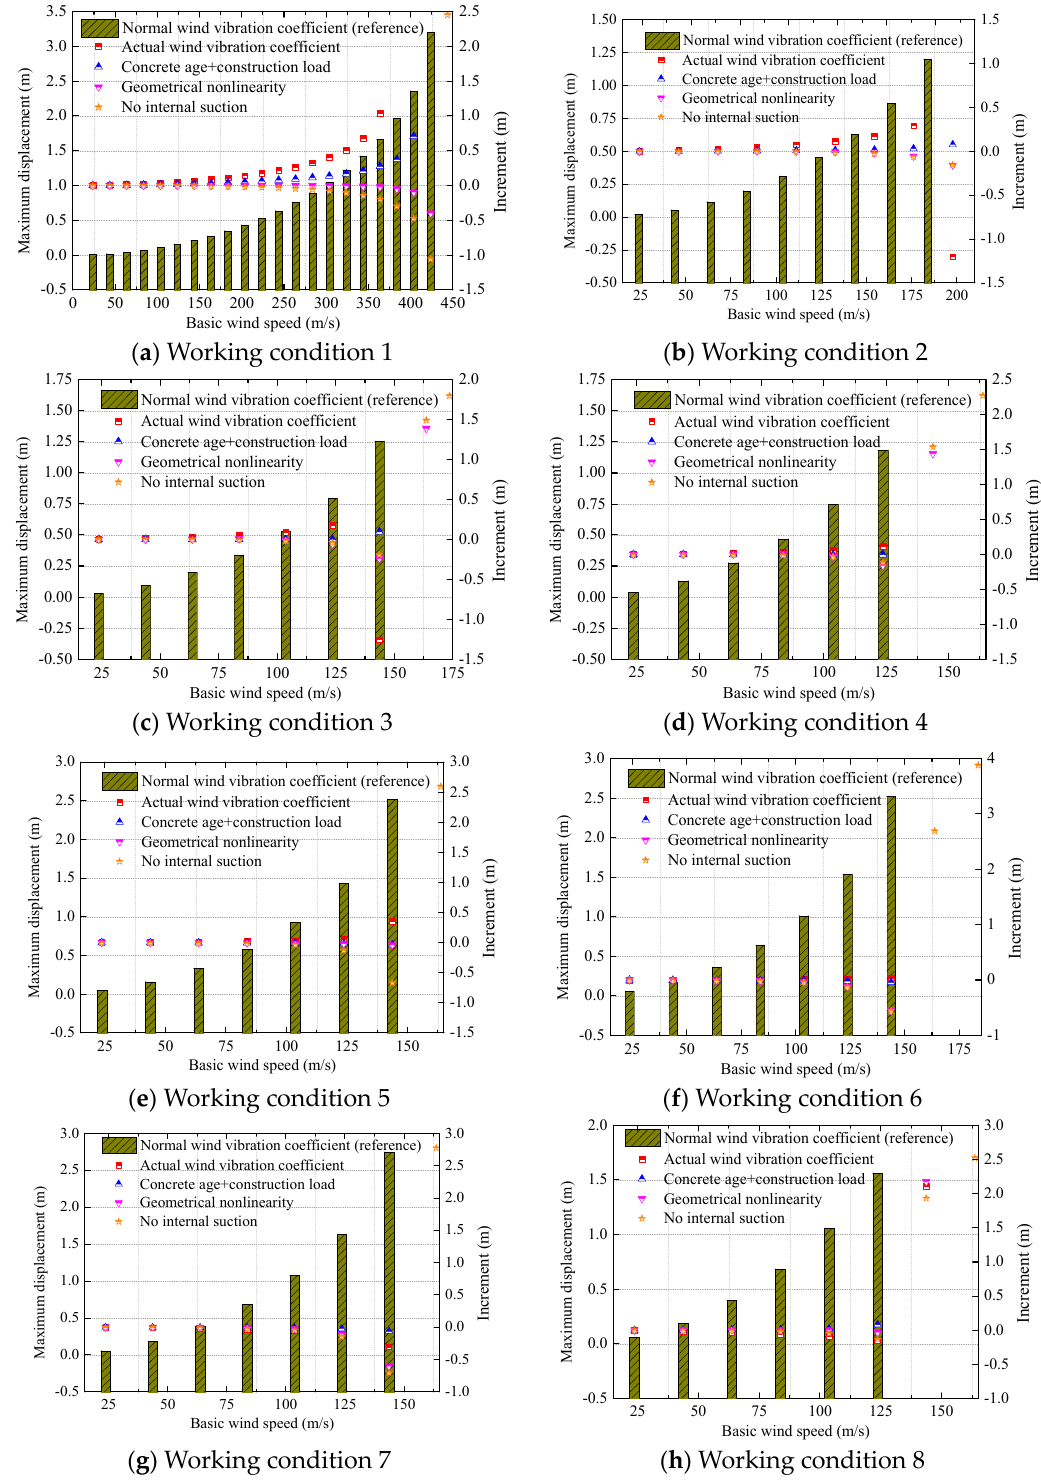
Figure 19. Changes of maximum displacement and increment with wind speed under eight working conditions.